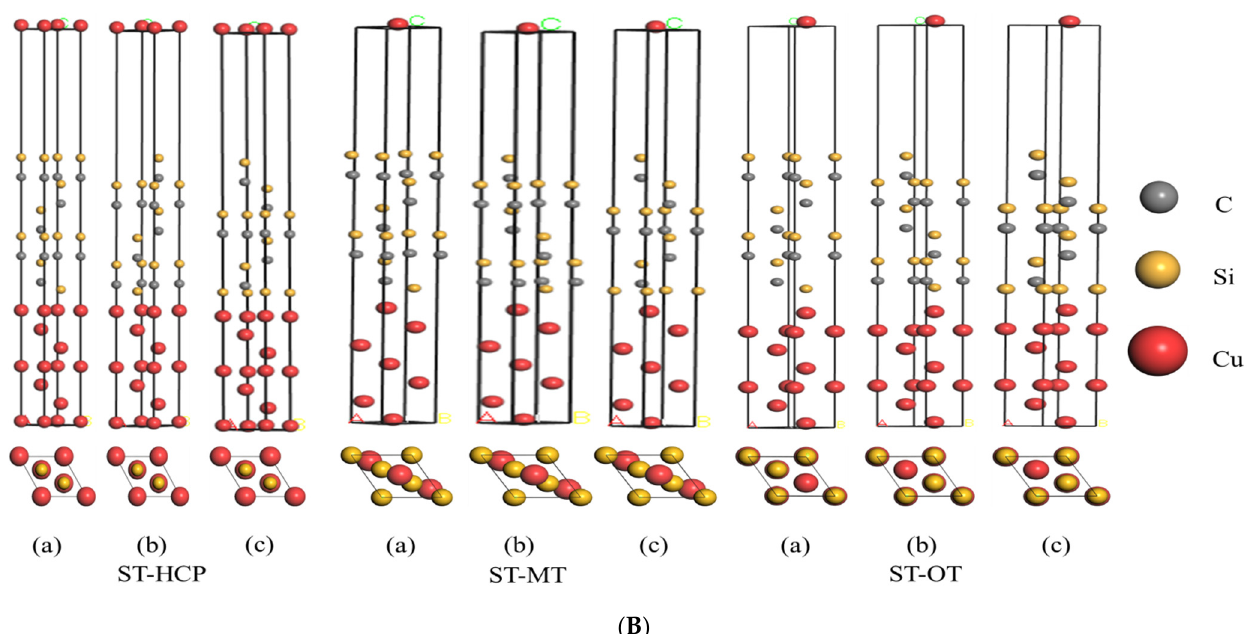
Figure 1. 6H-SiC Reinforced Copper Matrix Composite Models: ( A ) Carbon-terminated (CT)-6H- SiC(0001)/Cu(111) interfacial models, ( B ) silicon-terminated (ST)-6H-SiC(0001)/Cu(111) interfacial models. The above graphs represent side views of the 6H-SiC(0001)/Cu(111). Under the side view graphs is a top view of the 6H-SiC(0001)/Cu(111).